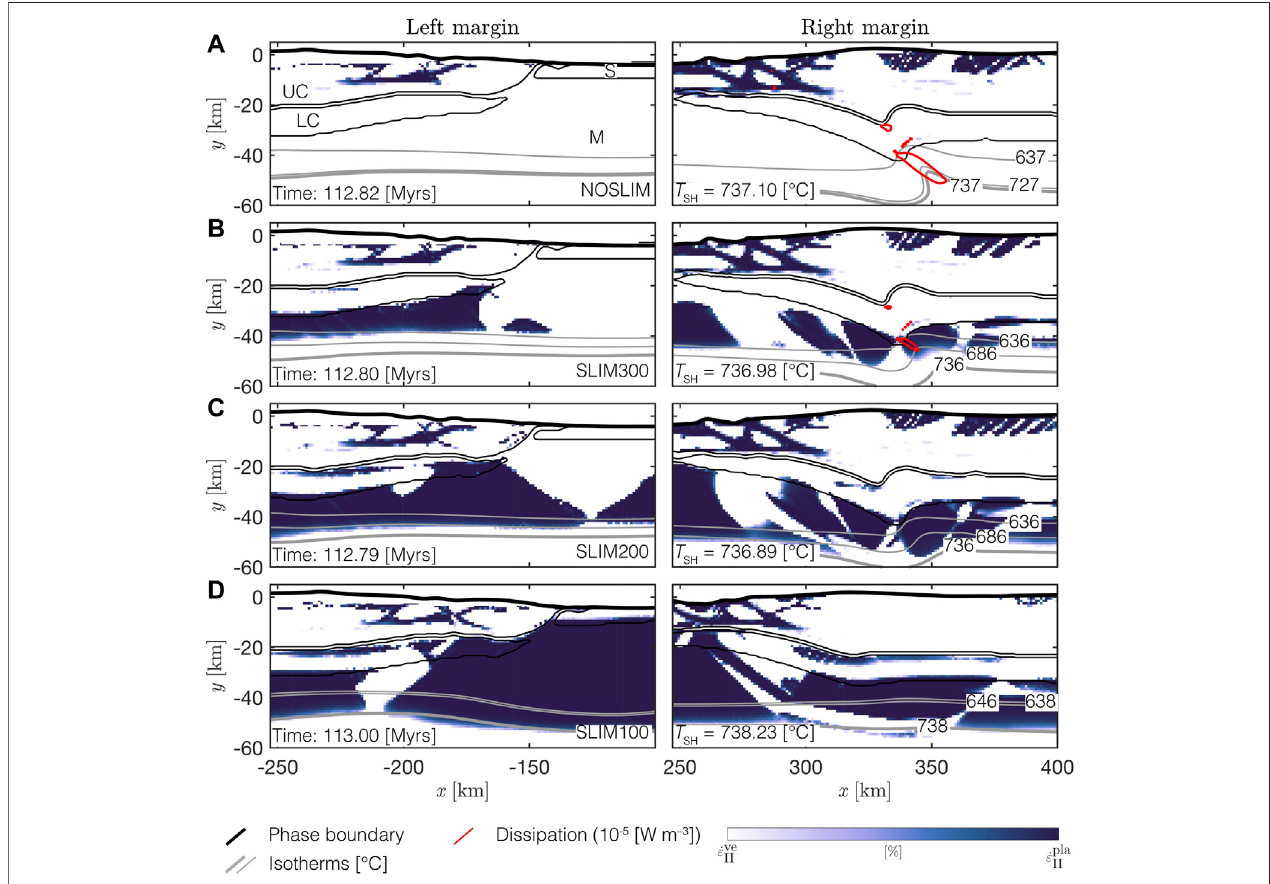
FIGURE5| Subductioninitiationviathermalsofteningformodelswithdifferentappliedstresslimits: (A) nostresslimit, (B) 300MPa, (C) 200MPaand (D) 100MPa. White to dark blue mark the model region that undergo rate-dependent (viscoelastic, white) or rate-independent (brittle, blue) plastic deformation. Solid grey lines are severalisothermsusedtoestimatethetemperatureriseinsidetheshearzonebasedontheirverticalposition,theredcontourindicatesthedissipationandblacklinesare material phase boundaries. The left column shows the left margin and the right column shows the right margin. When no stress limit is applied (NOSLIM) the emerging shear zone and large parts of the plate deform ductilly. With decreasing stress limit, large portions of the plate deform brittle-plastically.